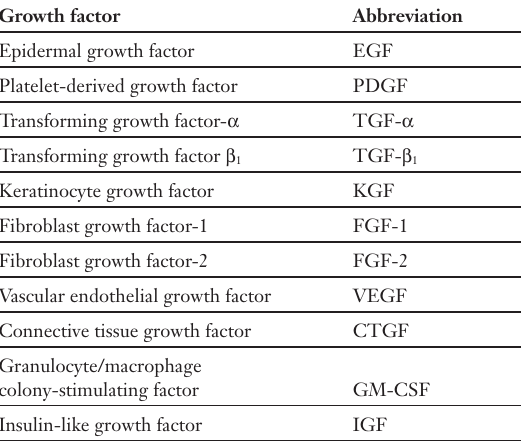
Growth factors con- tained in platelets. [Adapted and modi- fied from: Rozman P, Bolta Z. Use of plate- let growth factors in treating wounds and soft tissue injuries. Acta Dermatovenerol Alp Panonica Adriat.